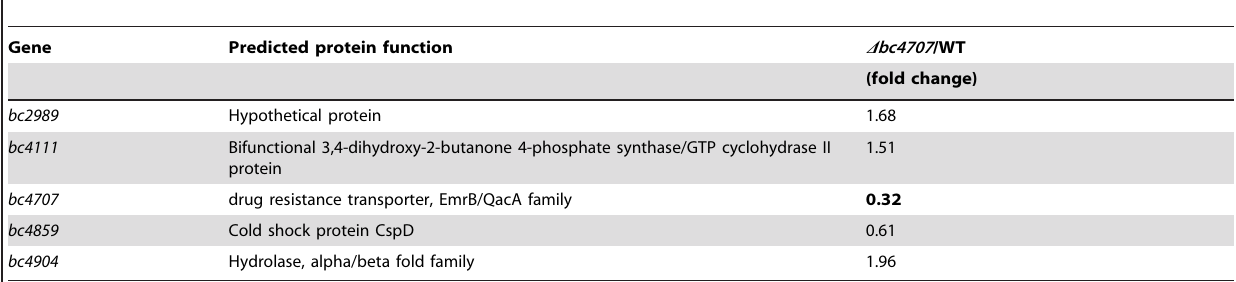
Table 1. Transcriptional profile of B. cereus ATCC14579 D bc4707 (AH1598) compared to wild type (AH1709) grown to logarithmic stage (OD 600 , 0.5) in rich medium followed by bile salt stress for 15 min.